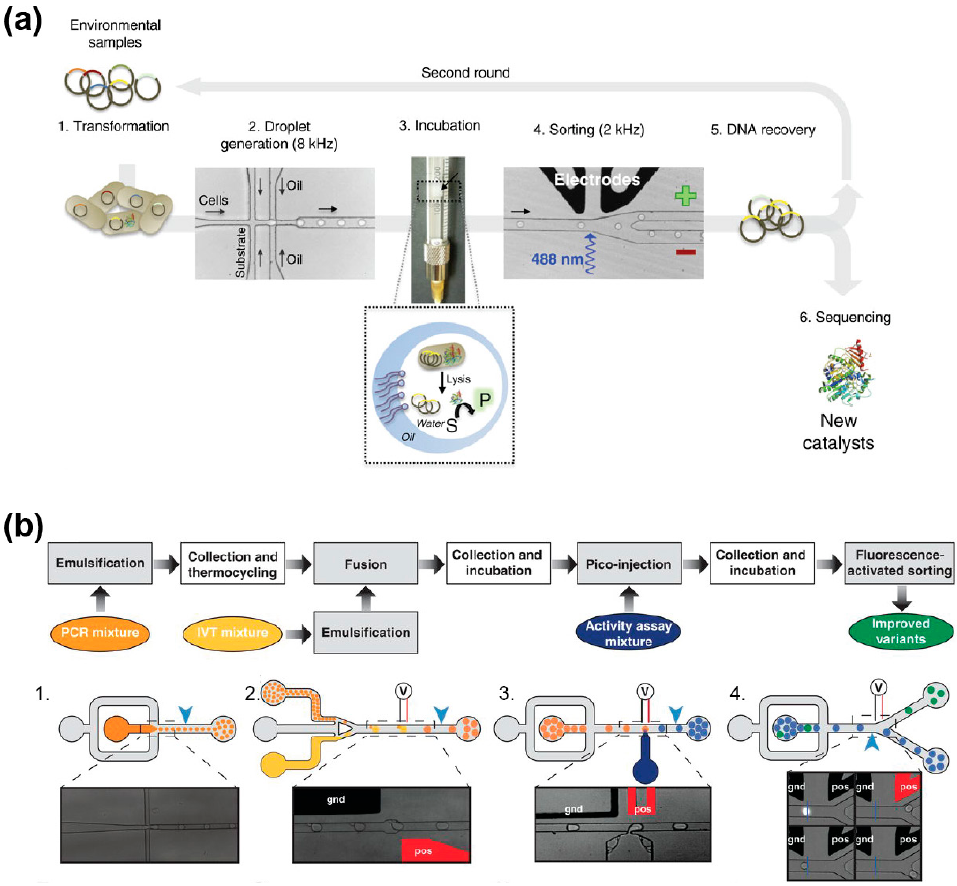
Figure 7. Microfluidic workflow for directed evolution of biological catalysts. ( a ) Cell-based